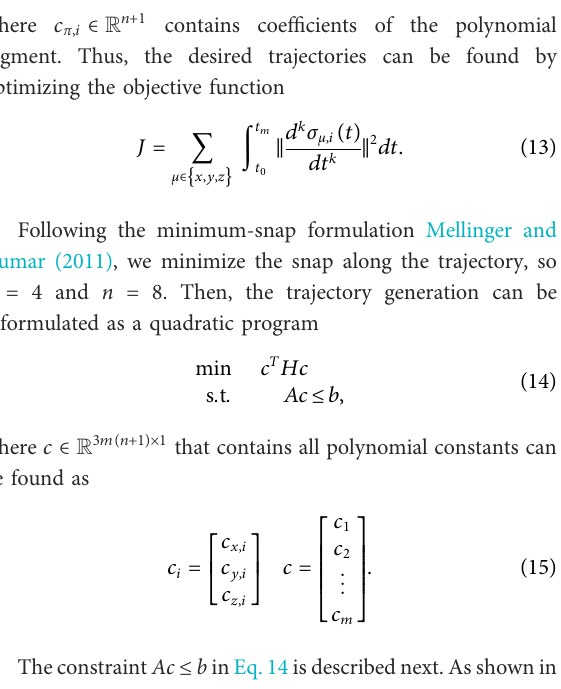
Figure 5, the target aerial robot is assumed to follow a constant velocity v T (cid:2) _ p T in the world frame. The position of the target is measured as p T ( t 0 ) in the world frame at time t 0 . Projected